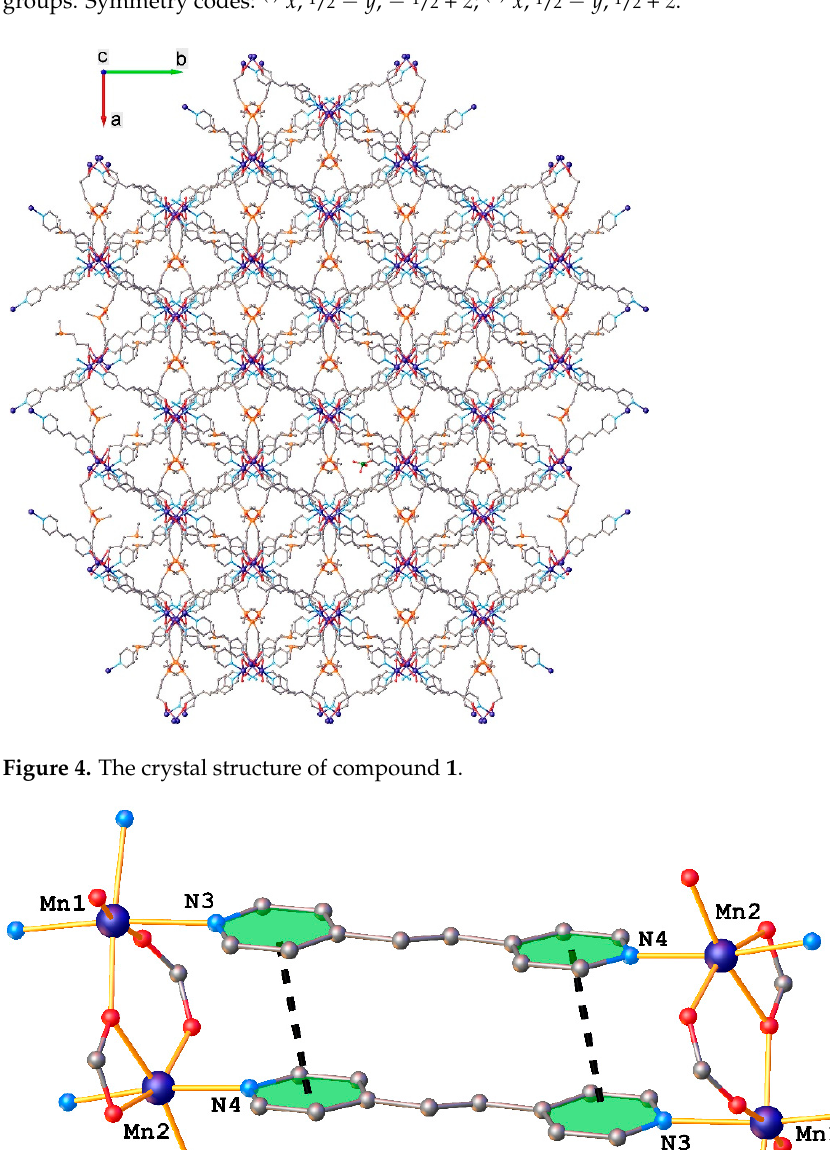
Figure 3. The 1D arrangement of metal ions, highlighting the coordination functions of the carboxylate groups. Symmetry codes: ( i ) x , 1 / 2 − y , − 1 / 2 + z ; ( ii ) x , 1 / 2 − y , 1 / 2 + z .